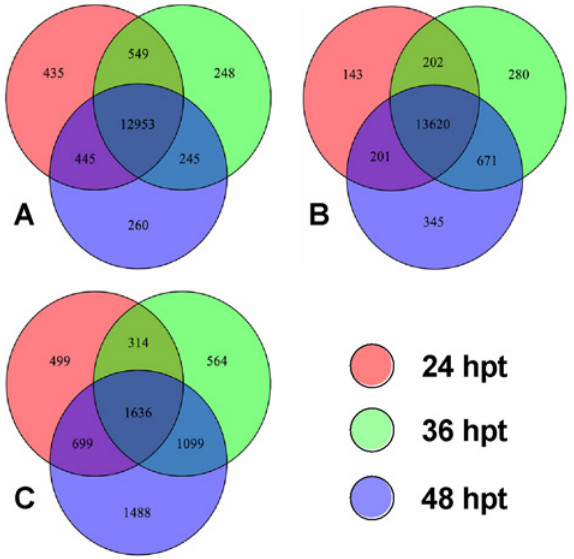
Fig 2. Venn diagrams for gene expression in P . xylostella and B . bassiana . ( A, B ) Counts of P . xylostella genes expressed respectively in the control (uninfected) and infected larvae at 24, 36 and 48 h post treatment (hpt). ( C ) Counts of B . bassiana genes expressed in the infected P . xylostella larvae at the three time